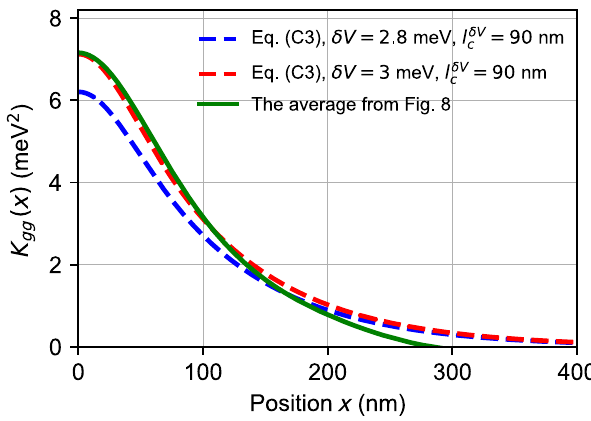
FIG. 17. Correlation function of the matrix element for the electron occupying ground orbital state K gg ( | x | ) . With dashed lines we plot numerically integrated formulas Eq. (C3) assum- ing exponential form of the correlation function of effective 1D δ V potential (cid:11) δ V ( x )δ V ( 0 ) (cid:7) = δ V 2 e −| x | / l c , with l δ V c = 90 nm and two values of noise amplitude δ V = 2.8 meV (blue) and δ V = 3 meV (red). For comparison using the green solid line we plot K gg ( | x | ) , obtained from the numerical averaging of different realizations of electrostatic disorder (see Fig.